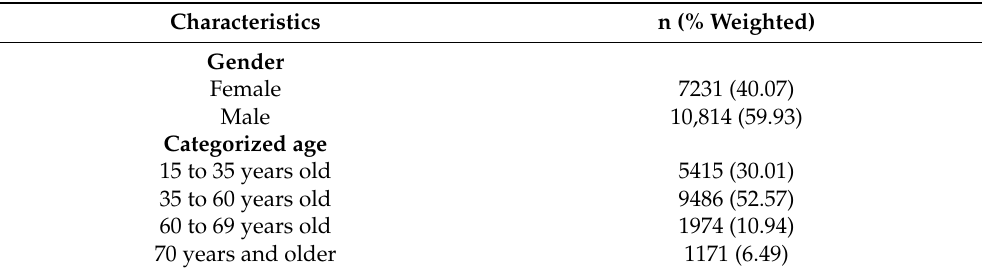
Table 1. Descriptive characteristics of factors associated with depressive symptoms in patients with